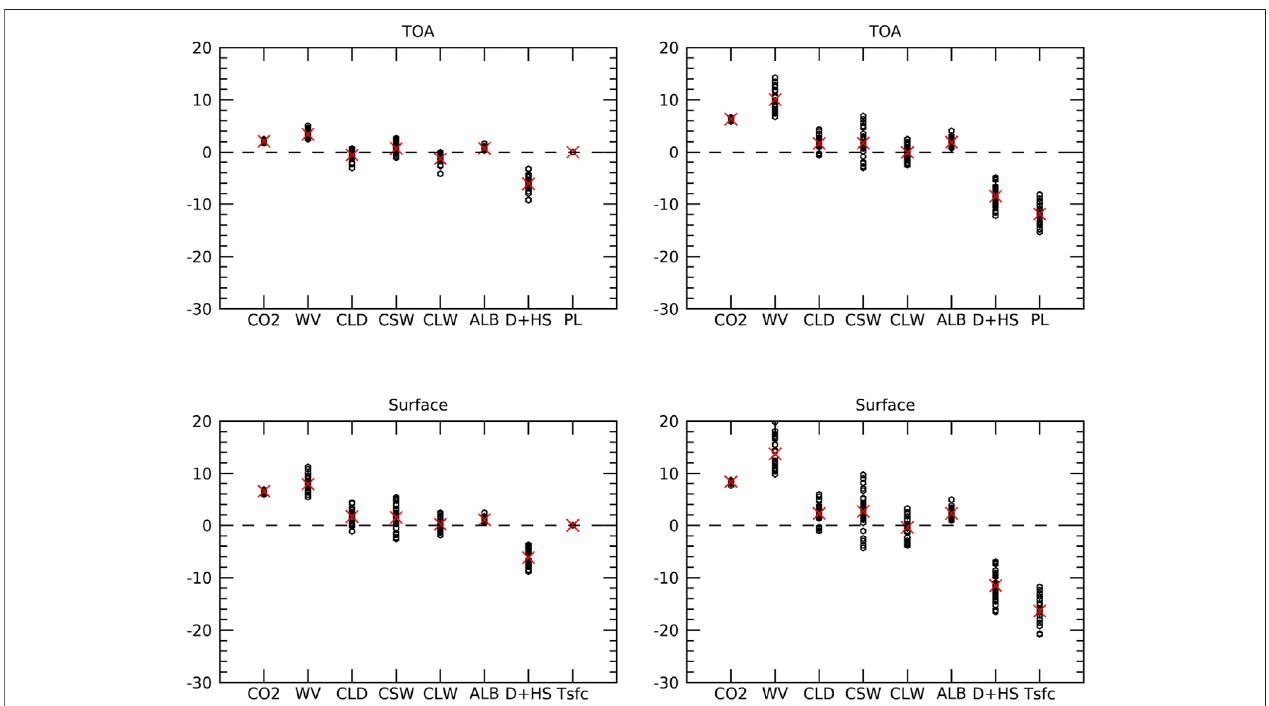
FIGURE 4 | The global-mean decomposition of the net energy fl ux change (W*m − 2 ) due to the lapse-rate feedback at the TOA (upper-left) and due to the atmospheric temperature feedback at the surface (bottom-left) . The sum of the left column with the corresponding direct impacts of CO 2 (CO2), water vapor (WV), clouds (CLD), SW clouds (CSW), LW clouds (CLW), surface albedo (ALB), dynamics plus heat storage (D + HS), Planck (PL), and surface temperature (Tsfc) given in Figure 1 provides the total contribution of these processes at the TOA (upper-right) and surface (bottom-right) , respectively. Black circles indicate individual CMIP5 model results, while red crosses show the CMIP5 ensemble